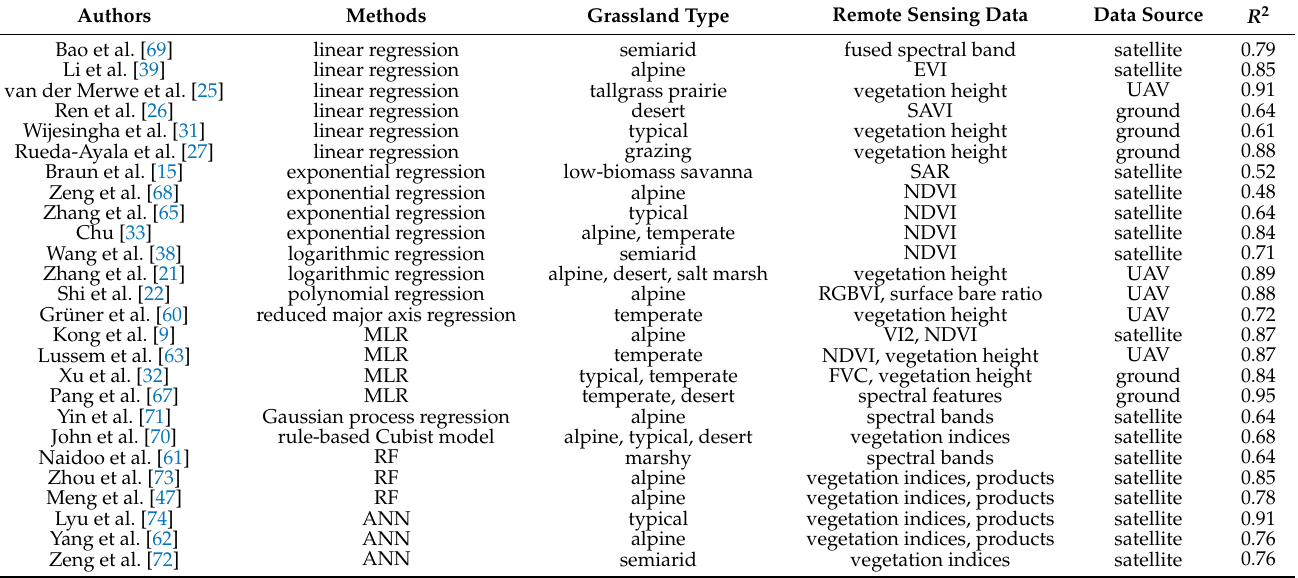
Table 2. Detailed information on the involved estimation studies for the